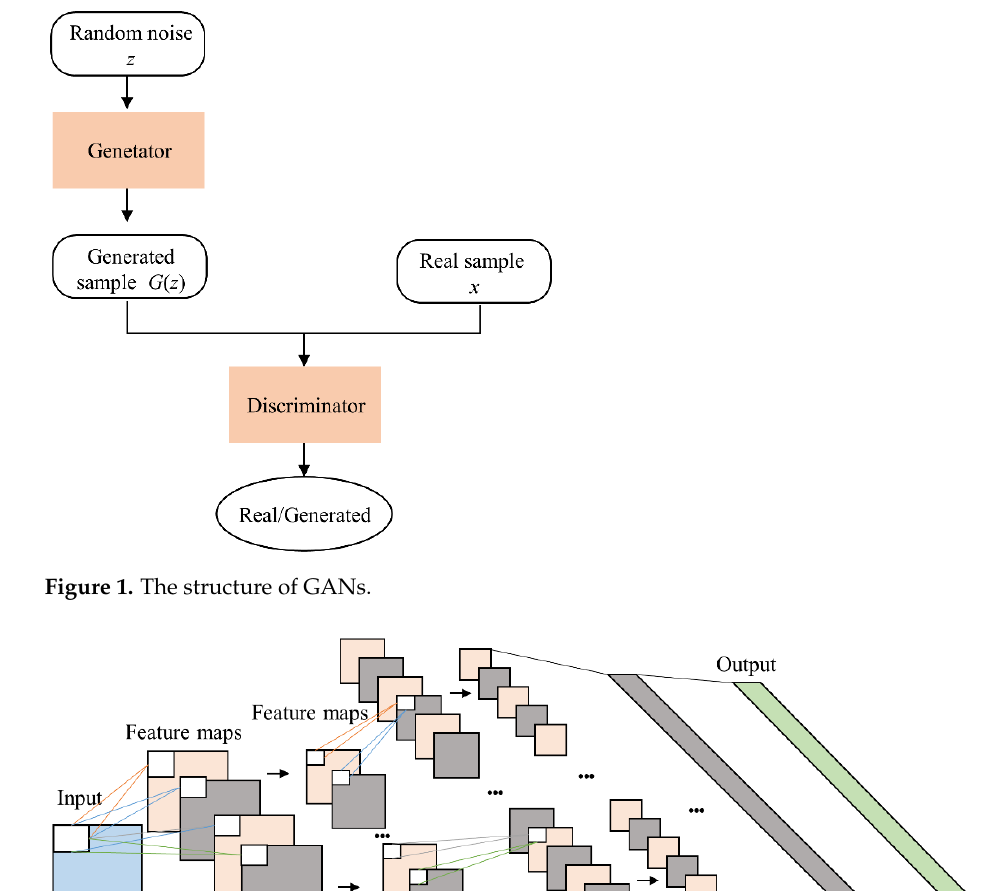
Figure 1. The structure of GANs.